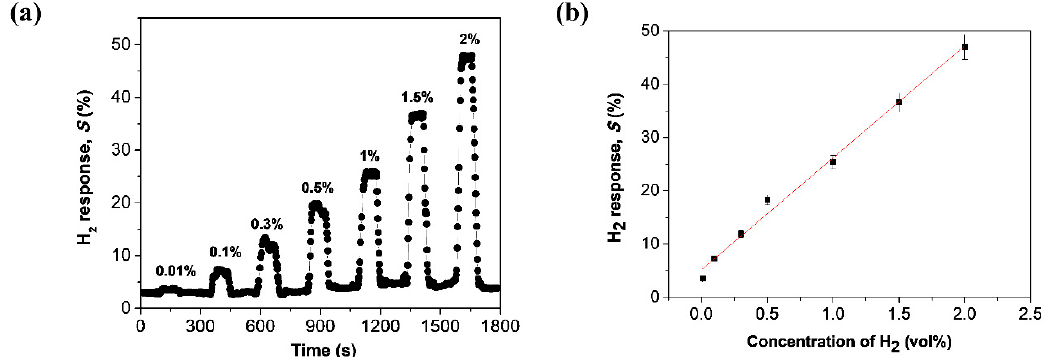
Figure 2. (a) Gas-sensing response of the P–PANI–GO-based sensor to different concentrations of hydrogen at room temperature; (b) The linear response for gas concentration in the range from 0.01 to 2 vol% [70] . Copyright (2020), with permission from Elsevier.